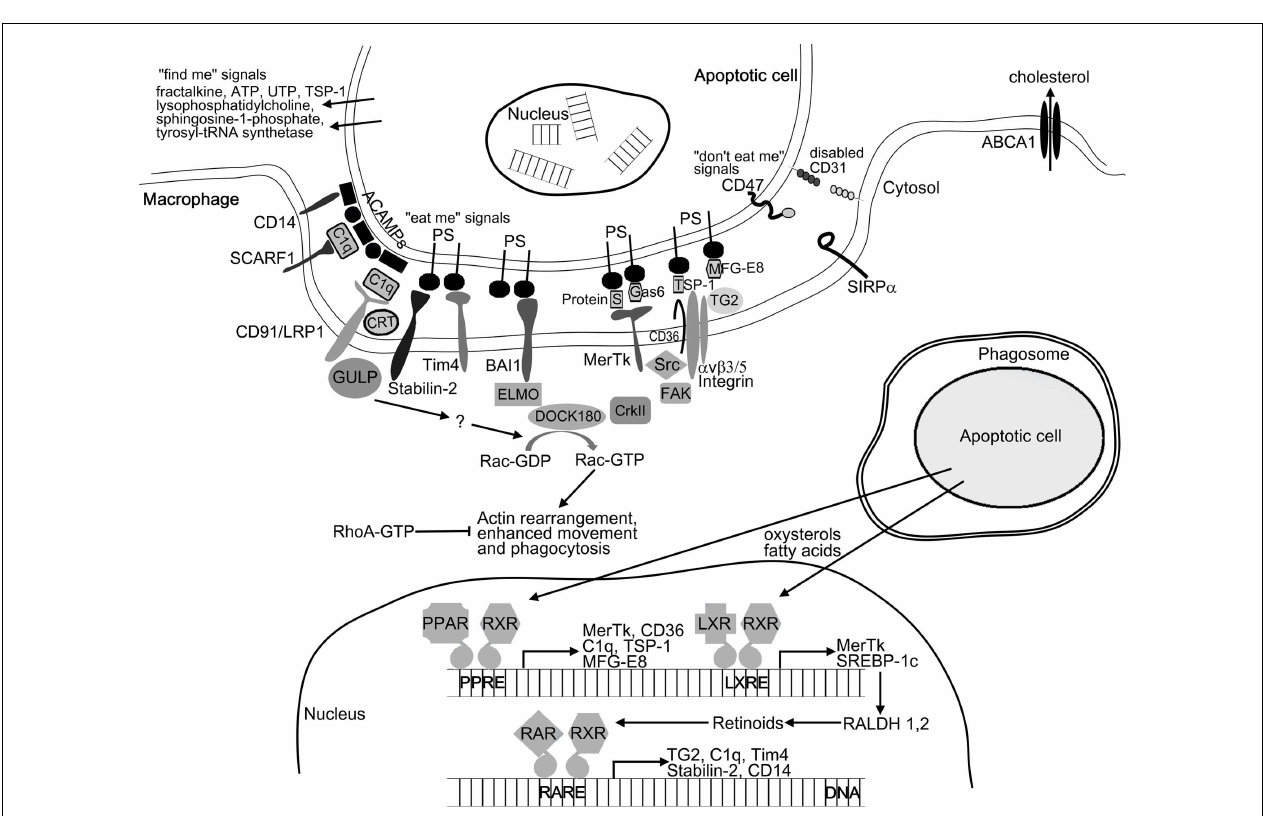
receptors triggers two evolutionary conserved signaling pathways. MerTk, BAI1, and α v β 3/5 receptors will activate the DOCK180/CrkII/ELMO complex, while CD91/LPR1 and stabilin-2 will activate the adaptor protein GULP. Both pathways converge on the small GTPase Rac, which initiates actin rearrangement and phagocytosis. Following engulfment, apoptotic cell derived lipids (oxysterols and fatty acids) trigger the lipid-sensing LXR and PPAR receptors leading to enhanced retinoid production. Retinoid receptors together with LXR and PPARs upregulate a number of phagocytic receptors to further enhance the engulfing capacity of macrophages under conditions when the rate of apoptosis is